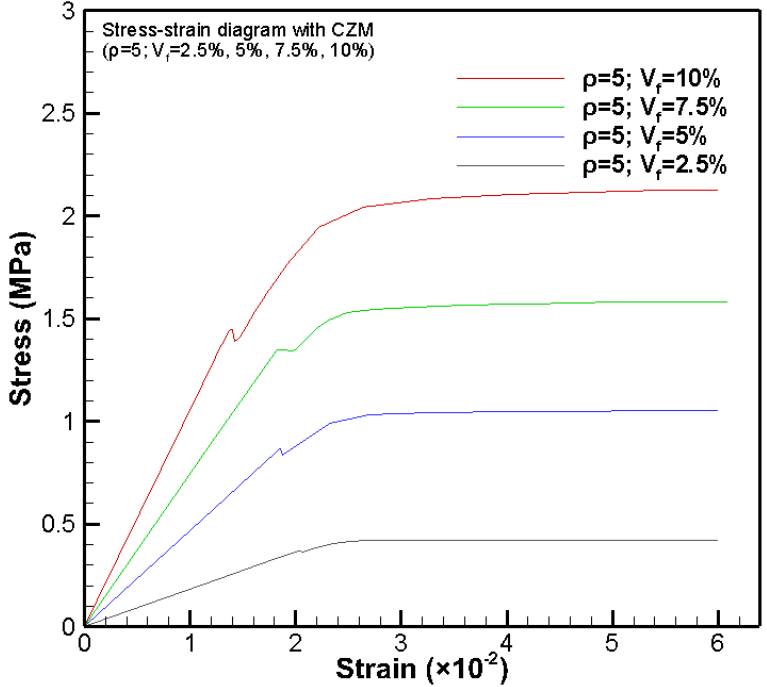
Figure 10. Effective stress-strain diagrams of the PNC (stack nanoparticle configuration) with CZM at the nanoparticle volume fraction of V f = 2.5%, 5%, 7.5% and 10%, respectively ( ρ = 5).